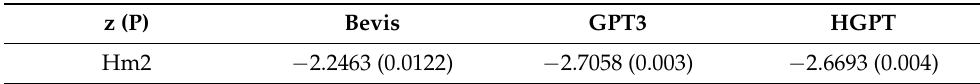
Table 8. The statistic z and corresponding p